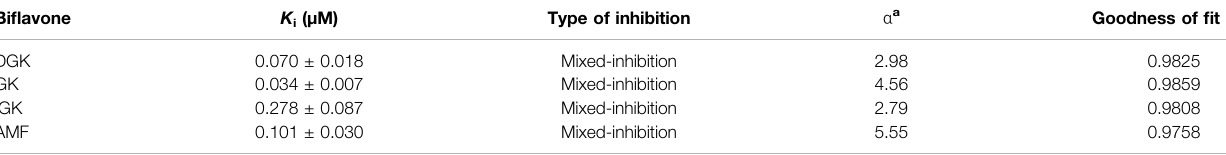
TABLE 2 | Inhibition parameters of inhibitory constitutes toward CYP3A4 in human liver microsomes. Bi fl